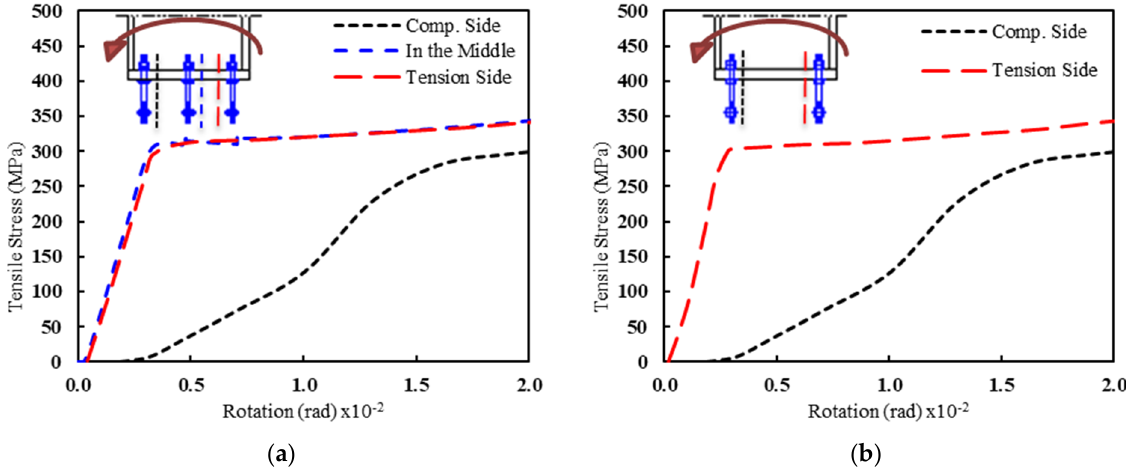
Figure 20. Tension stresses in the anchor bolts vs. rotation for specimens with T = 24 mm, D = 18 mm, and S = 150 mm. ( a ) B4-D18-S150-T24 and ( b ) B6-D18-S150-T24.